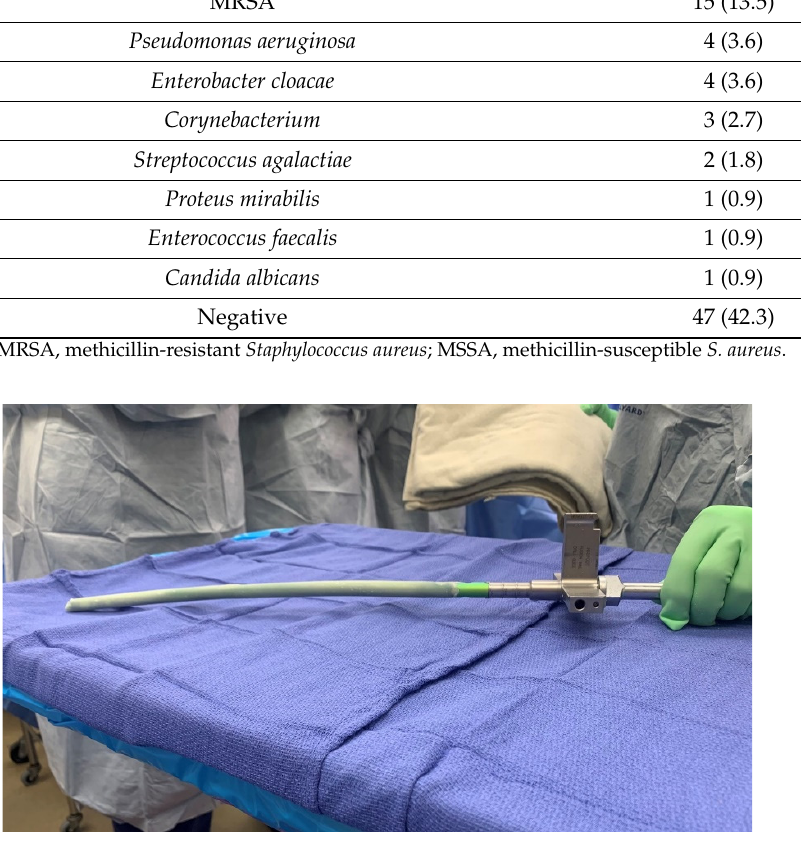
Figure 1. Photo of an antibiotic-coated hindfoot fusion rod (Trigen; Smith & Nephew, Memphis, TN, USA). The width of the nail with cement is 12 mm.